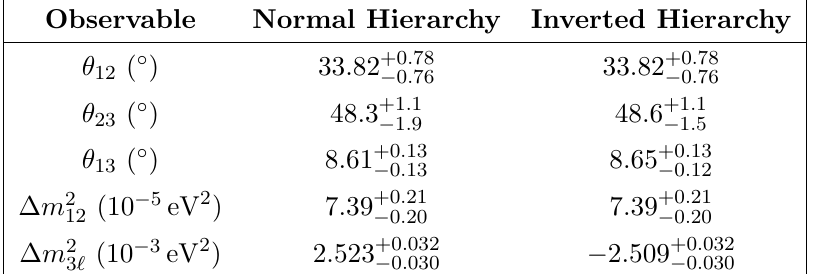
Table 1 . Global (cid:12)t on neutrino observables by NuFIT 4.1. (2019) [58]. Similar results have been found in [59,